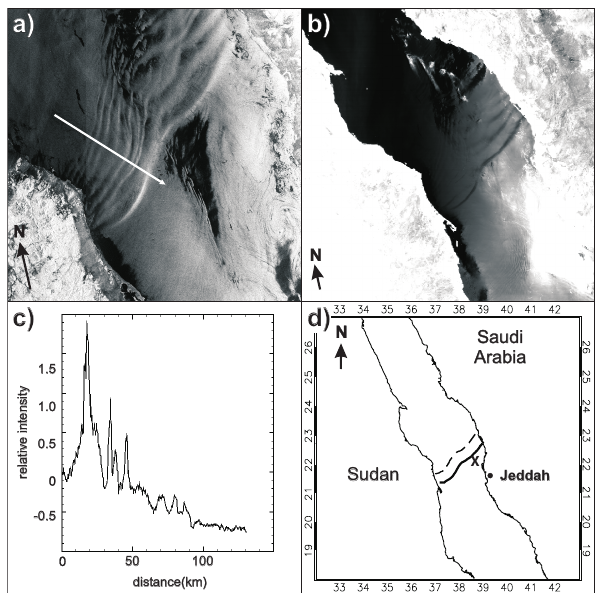
Fig. 1. Case study of an AGW occurrence in the Red Sea near Jed- dah: (a) subset of an Envisat-ASAR image acquired at 07:26 (UTC) dated 11 May 2004. A transect profile is marked with a white arrow across the AGW packet (extending from NW to SE); (b) subset of a near-infrared MODIS-Terra image acquired at 08:12 (UTC) dated 11 May 2004; (c) relative intensity taken from the profile in the Envisat-ASAR image in (a) ; (d) compiled feature map with the ge- ographic locations of the leading waves in (a) (dashed line) and (b) (solid line), X marks the location where in situ measurements were made (22 ◦ 04.509 0 N, 38 ◦ 46.181 0 E) near Abu